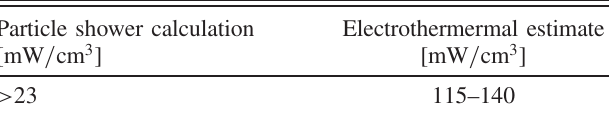
TABLE VI. Quench-level comparison of the FLUKA lower bound and the electrothermal MQPD estimate in the MB.A9L7 coil for the steady-state collimation quench test. The upper and lower values for the electrothermal estimate correspond to a cooling model with and without heat flow through the intralayer spacers, respectively.